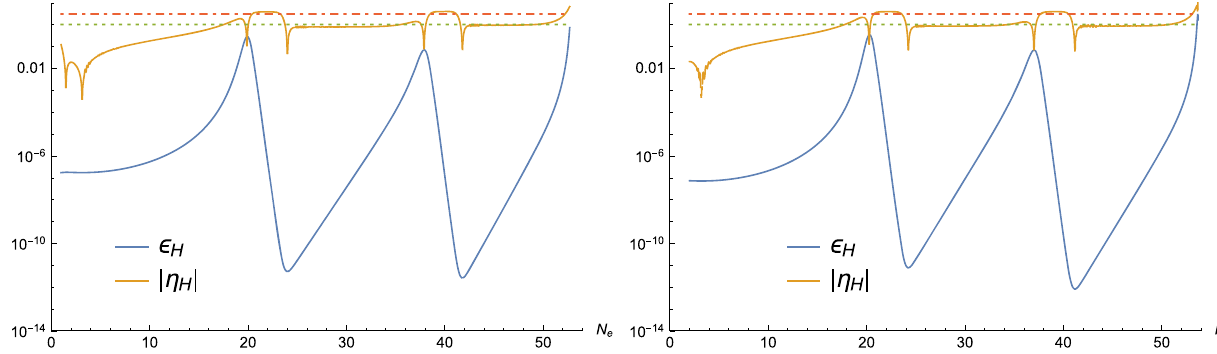
Fig. 3 Hubble slow-roll parameters (cid:19) H and η H as functions of the e-folding number N e in Model I for parameter set (20) (left panel), Model II for parameter set (23) (right panel). The dashed lines indicate the values 1 and 3